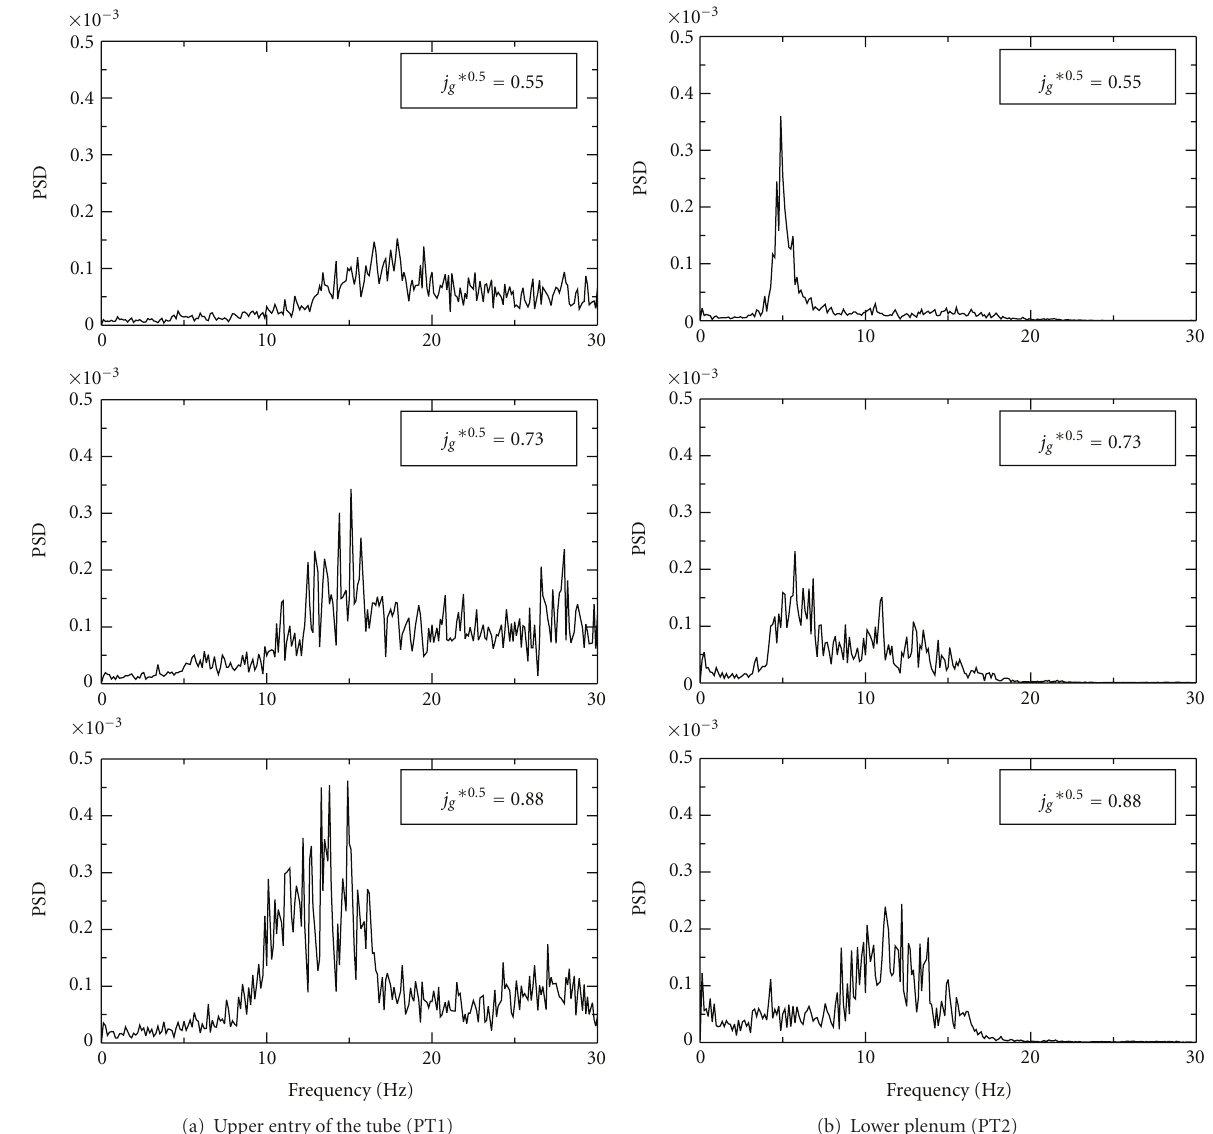
Figure 9: Power spectrum density (PSD) of pressure fluctuations for various air flow rate (tube diameter, D = 12 mm).